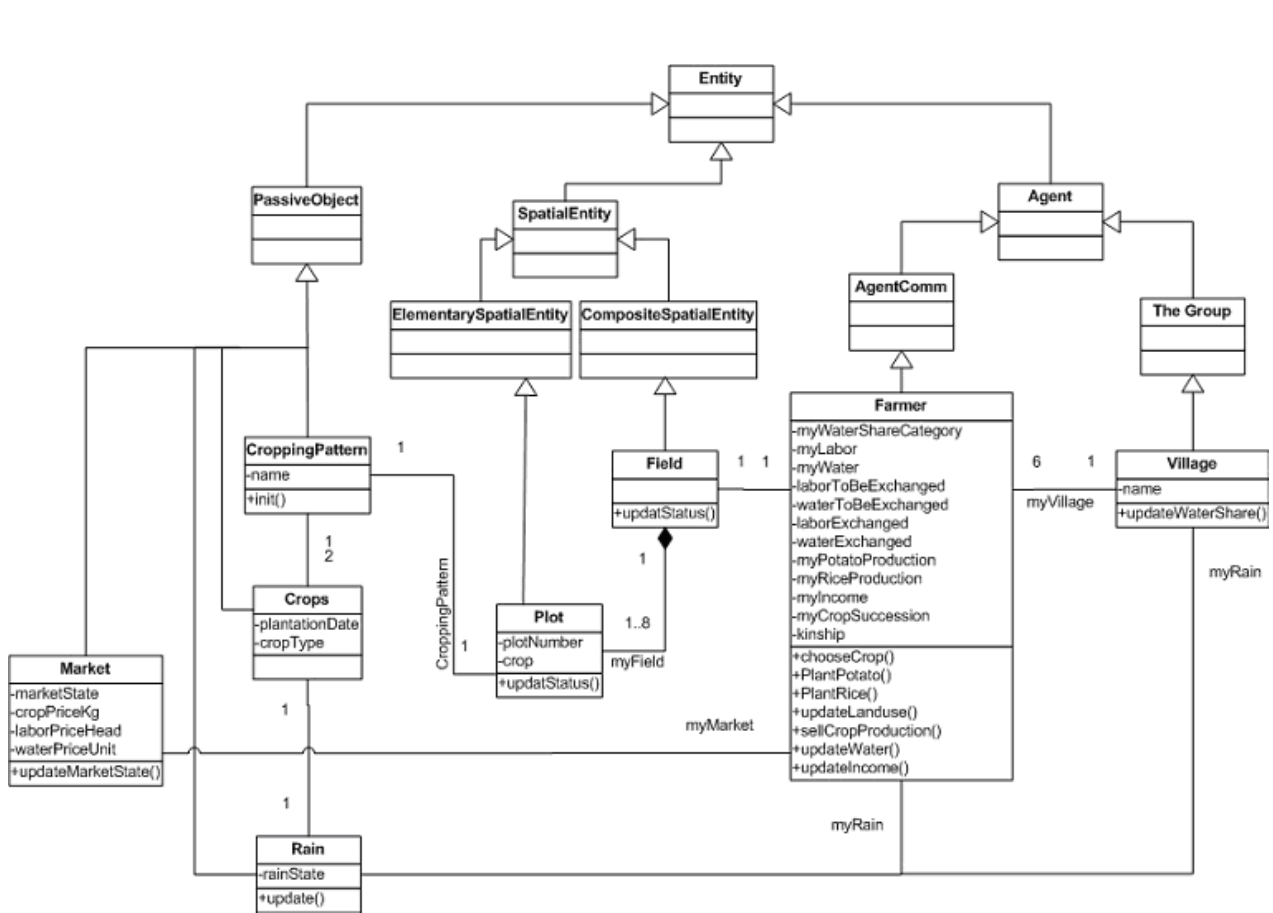
Fig. 5. Class diagram of the Limbukha